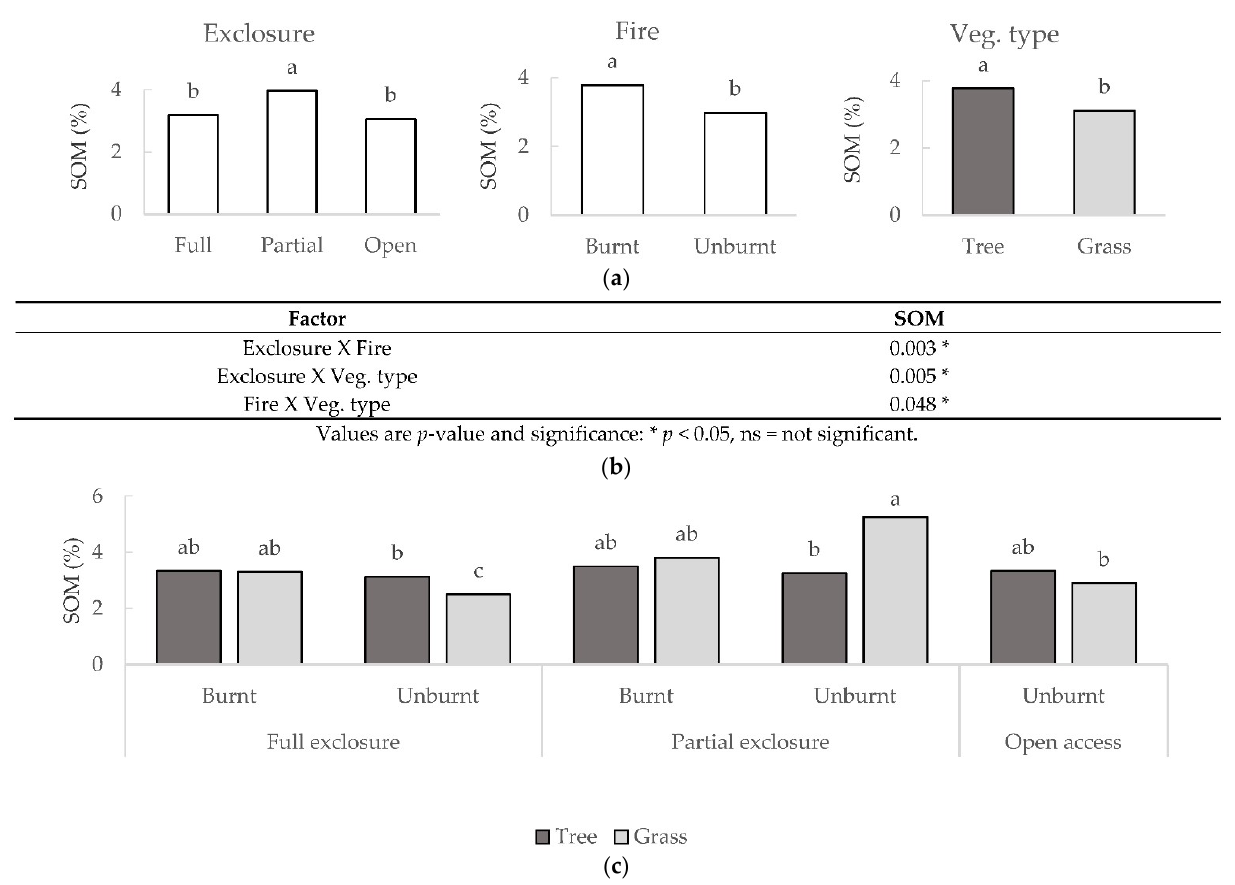
Figure 5. The main and interactive effect of herbivores, fire, and vegetation (veg.) type on soil or- ganic matter (SOM): ( a ) independent effect; ( b ) two-way interactive effect; ( c ) three-way interactive